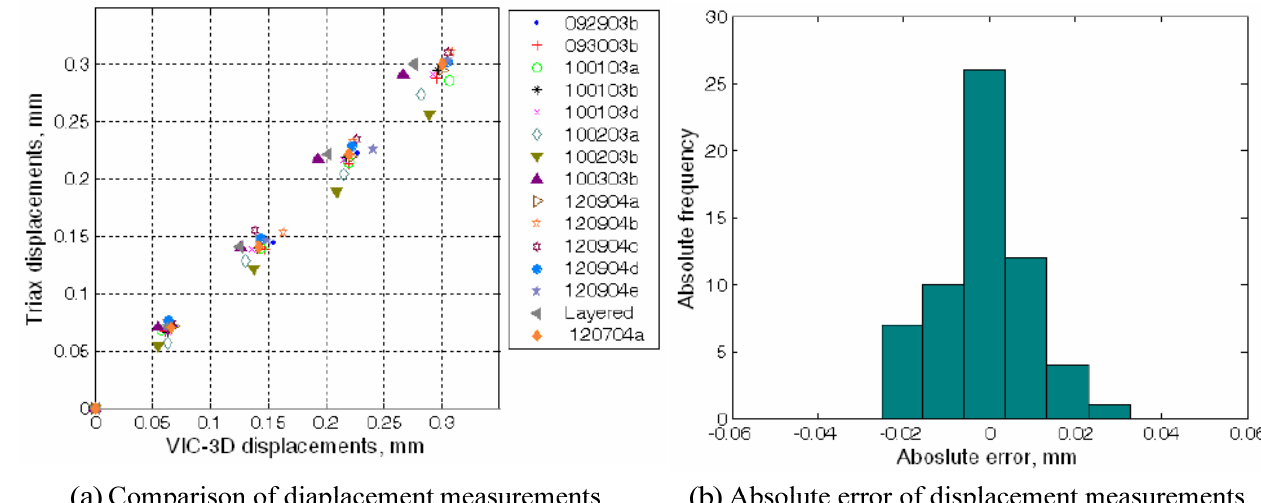
Figure 13. Accuracy analysis: Comparison of displacement measurements between the triaxial device LVDTs and VIC-3D displacement readings ( a ) and frequency histogram of absolute error of displacement measurements between the triaxial test system and VIC ‐ 3D ( b ).